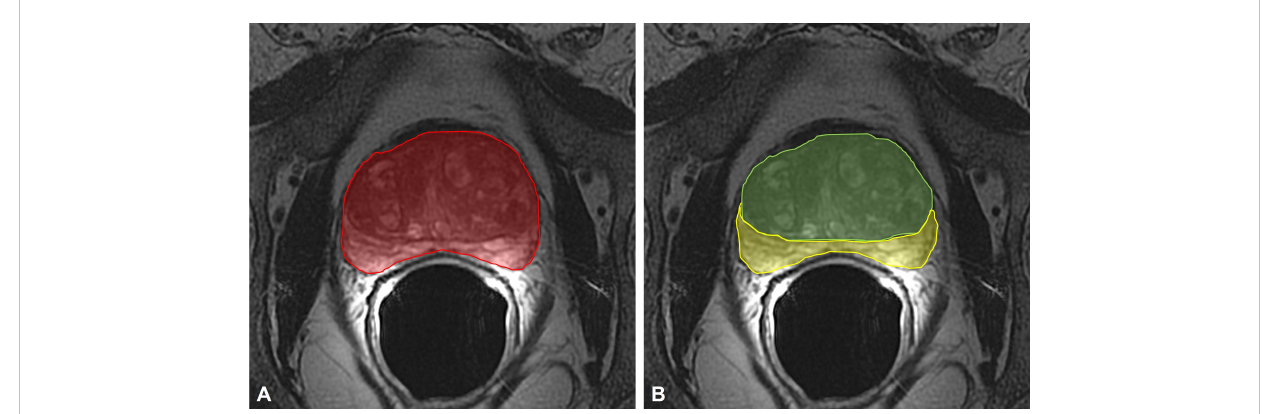
FIGURE 2 (A) measurement of the TransPA (red area) on the axial FR-FSE T2-weighted maximum sectional area of the prostate; (B) measurement of the TransCGA (green area) and TransPZA (yellow area) on the axial FR-FSE T2-weighted maximum sectional area of the prostate. TransPA, transverse prostate maximum sectional area; TransCGA, transverse central gland sectional area; TransPZA, transverse peripheral zone sectional area; FR-FSE, Fast Relaxation Fast Spin